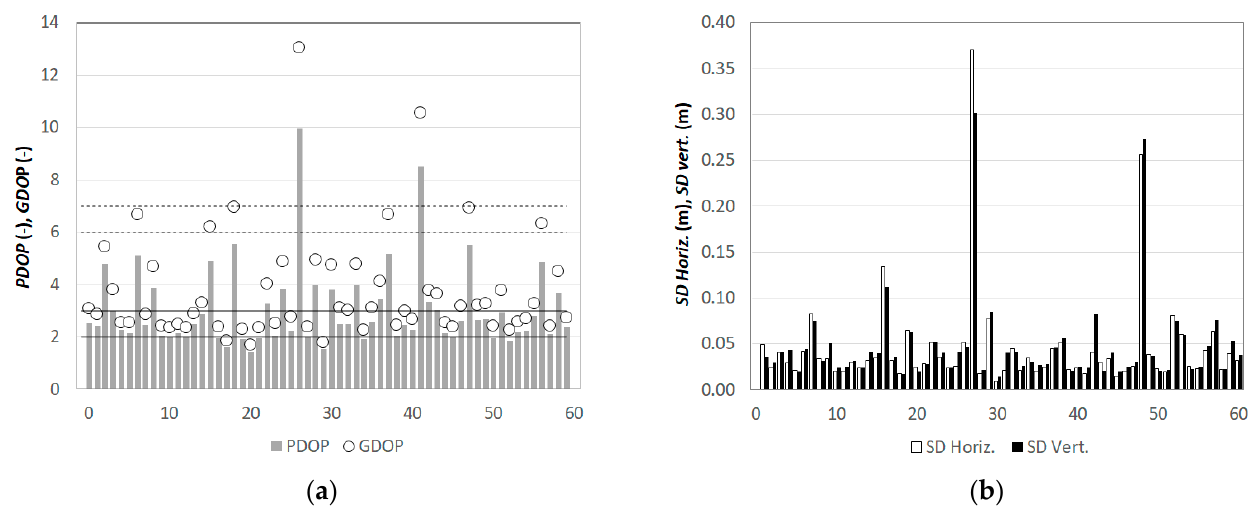
Figure 5. Precision and standard deviation of the GNSS solutions: ( a ) positional dilution of precision (PDOP, grey bars) and geometric dilution of precision (GDOP, empty dots). Overimposed the maximum suitable values for the PDOP (2–3, continuous lines) and the GDOP (6–7, dashed lines). ( b ) Standard deviation (SD) (m) of the planimetric components (SD Horiz., white bars) and the vertical component (SD Vert., black bars). Table 1. Descriptive statistics of ∆ E : mean, median, standard deviation, kurtosis, skewness, and IQR. ∆ E , ∆ N